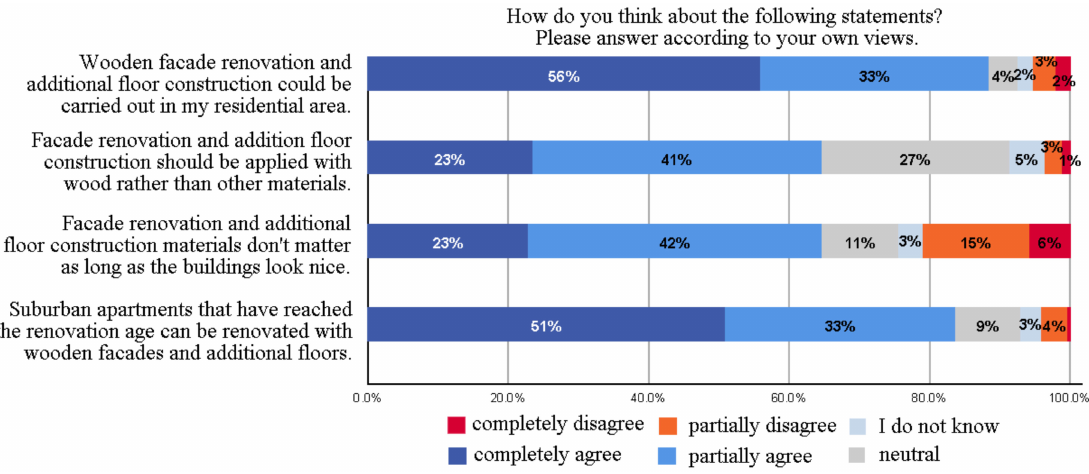
Figure 6. Preferences for additional